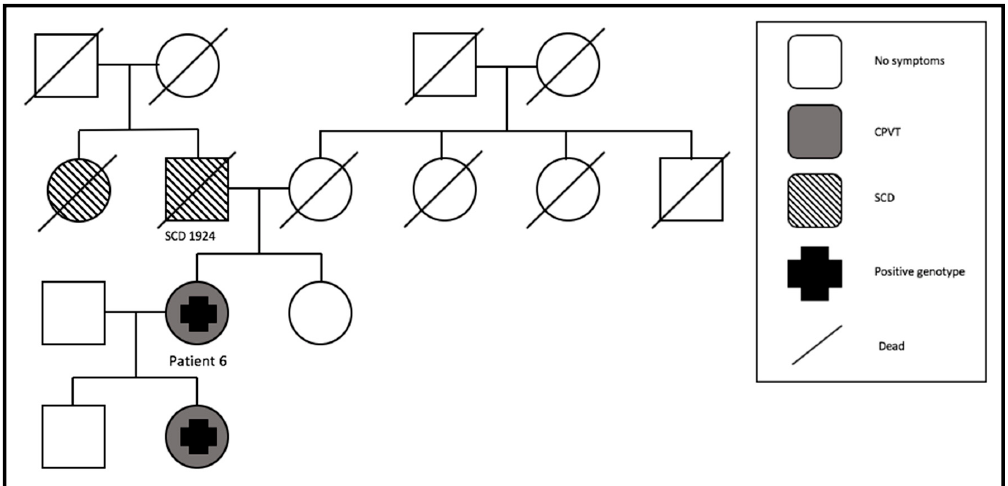
Figure 3. Pedigree of family 4. Two SCD cases (SCD = sudden cardiac death).